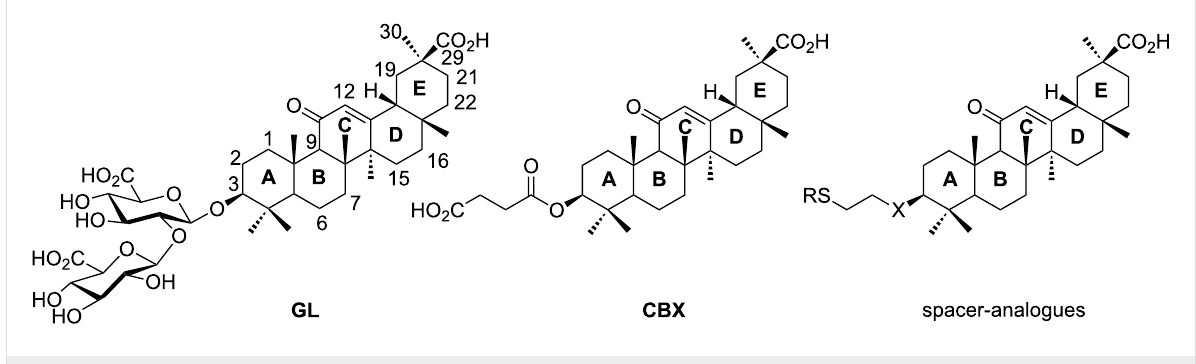
Figure 1: Structure of glycyrrhizin ( GL ), carbenoxolone ( CBX ), and spacer analogues.